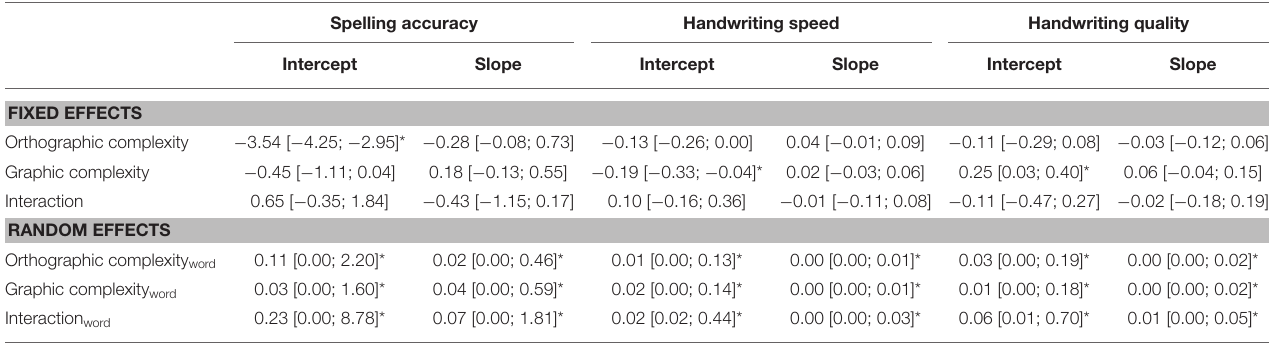
TABLE 6 | Estimates of the conditional linear growth curve models of spelling, handwriting speed, and handwriting quality on orthographic and graphic complexity in cohort 2.